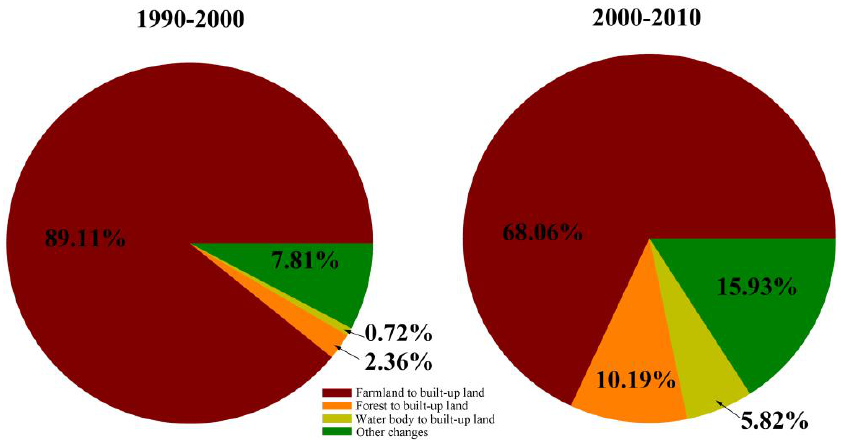
Figure 5. Dominant components of land-use change in the highway-effect zone.